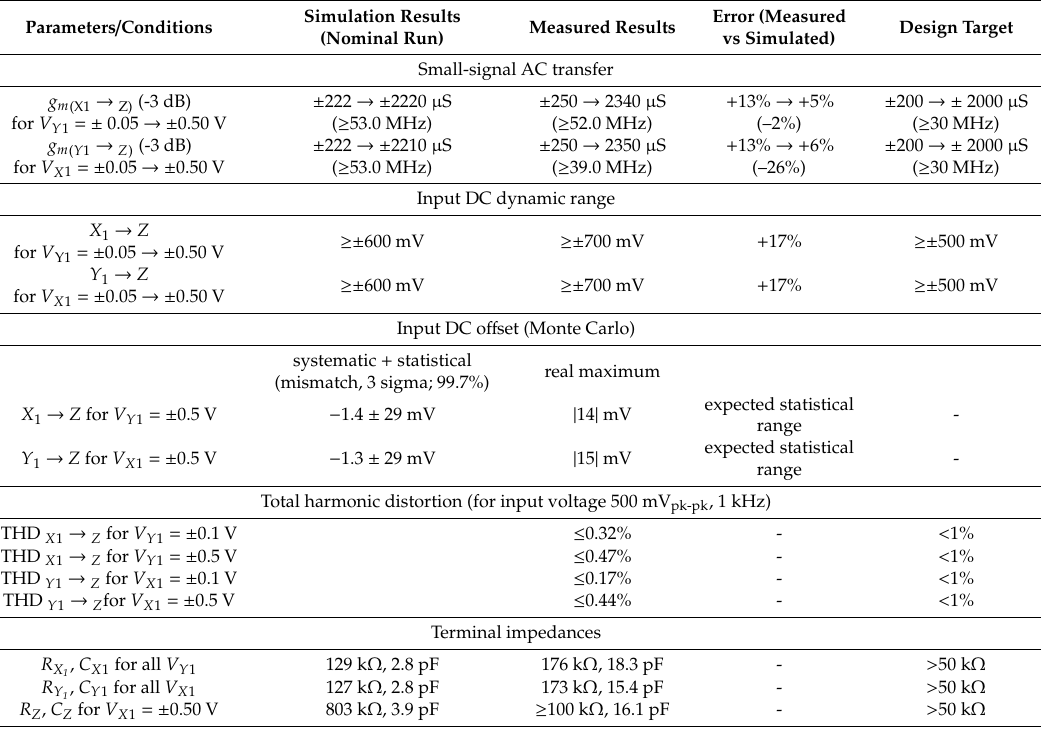
Table A3. Summary of simulated and measured performances of the BJT MTL cell.